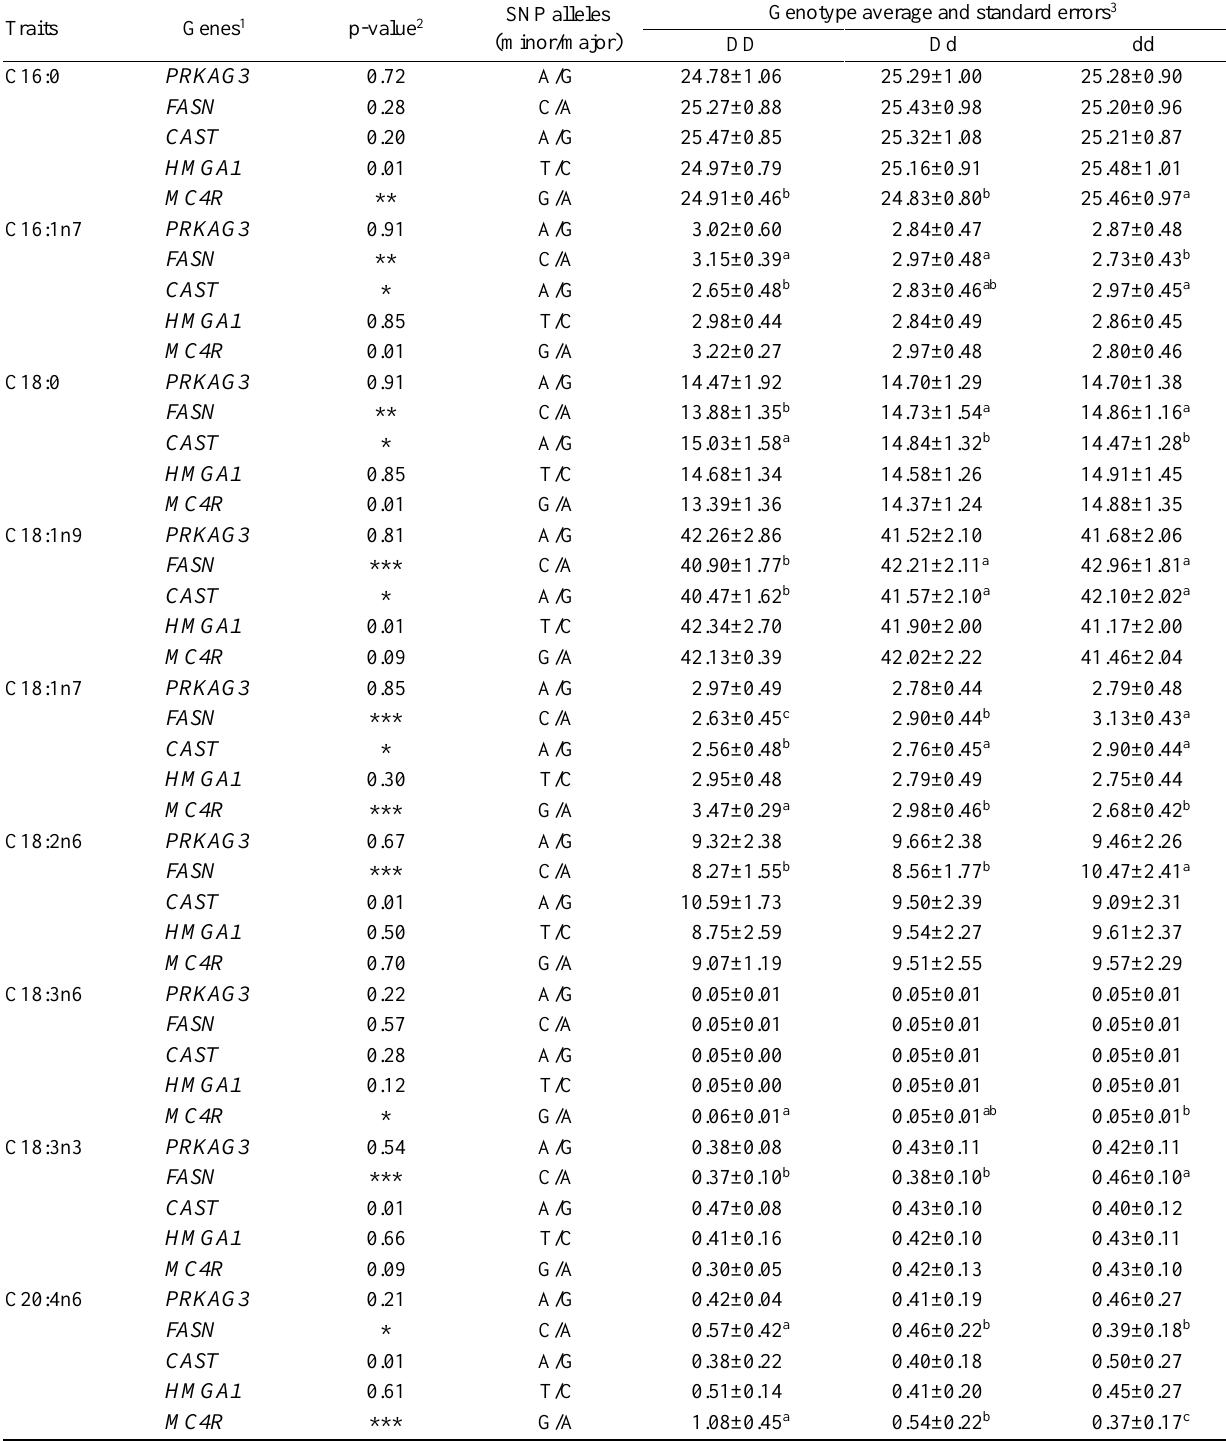
(C18:3n3), and poly-unsaturated fatty acid content than CC genotype. The meats from pigs that carry AA genotype of the CAST gene showed significantly lower content of mono-unsaturated fatty acids than the AG and GG genotypes. Cameron and Enser (1991) reported that flavor